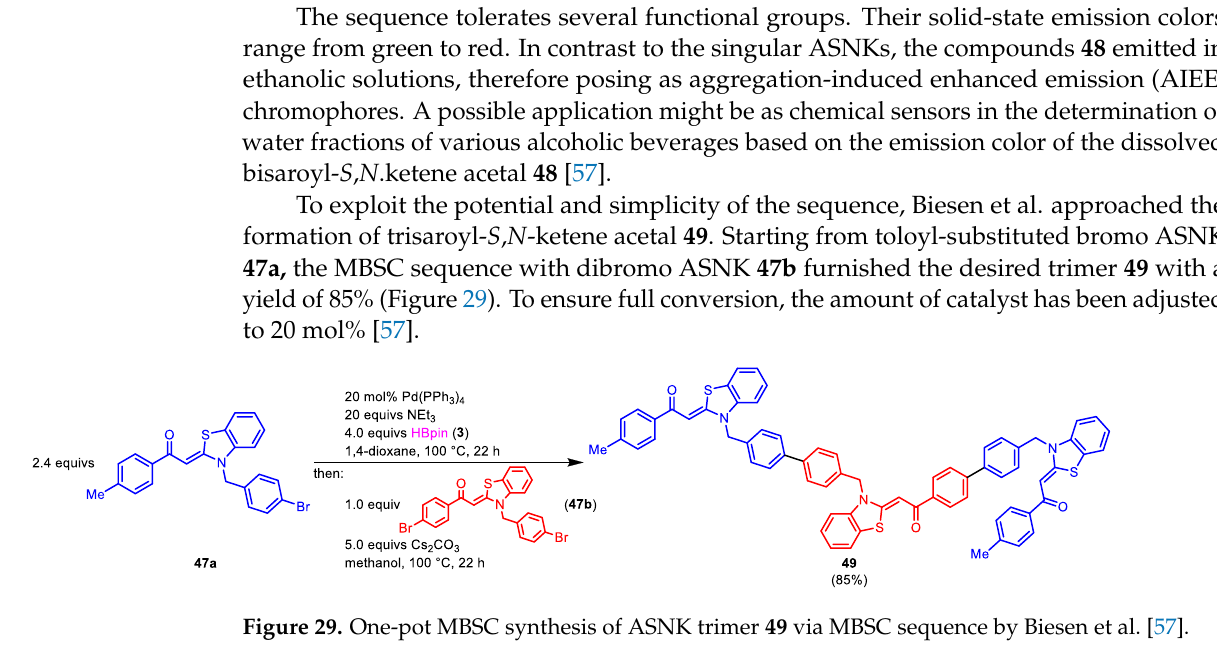
Figure 28. One-pot MBSC synthesis of bisaroyl- S , N -ketene acetals 48 by Biesen et al.[57]. The sequence tolerates several functional groups. Their solid-state emission colors